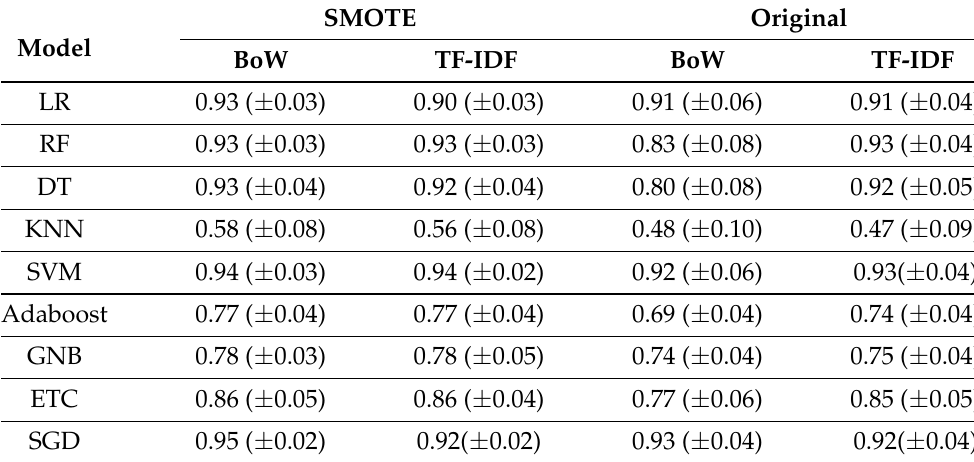
Table 16. 10-fold cross-validation results.